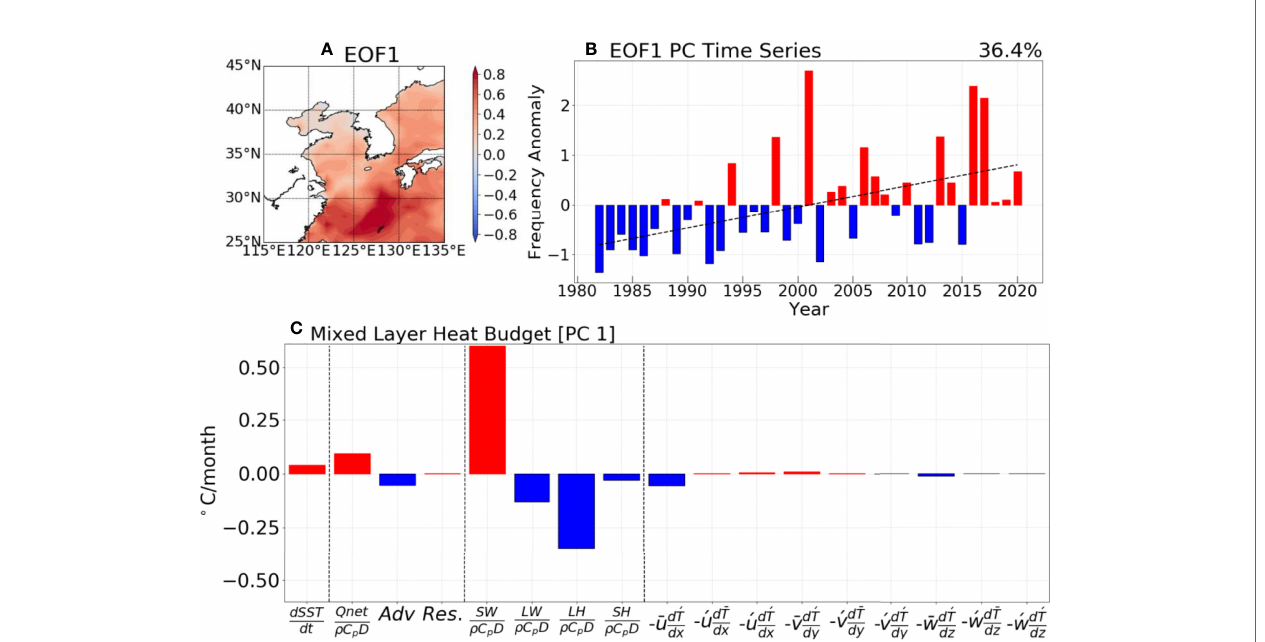
FIGURE 2 | (A) EOF1 spatial pattern of the total frequency of summer MHWs in EAMS, analyzed with ERA5 reanalysis data from 1982 to 2020. (B) The EOF1 PC time series as seen in (A) . The unit is loaded in the PC time series, not in spatial mode. (C) The bar plot of an area-averaged mixed layer heat budget regressed with EOF1 PC time series. Regression with PC indicates the contribution of each term to the change that occurs when the number of occurrences